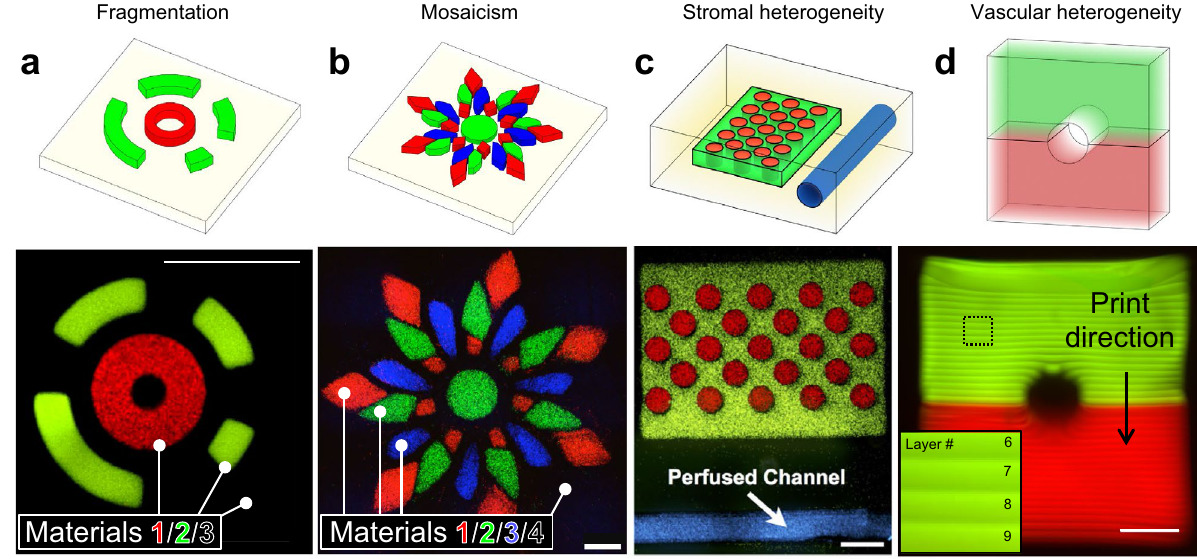
Figure 3. Multi-material printing of heterogeneous structures with broad design freedoms. ( a ) Annular hydrogel features with encapsulated fluorescent beads, printed atop a non-fluorescent base, yielding a monolithic 3-material structure with discrete, fragmented features at meso scale resolution (≈250 μm). ( b ) A 4-material floral mosaic. ( c ) A thick gel with stromal heterogeneity, featuring a hollow vessel that supported perfusion with blue fluorescent beads. ( d ) Side view of a two-component vessel (fluorescent dextrans encapsulated); inset highlights void-free covalent lamination between print layers. All scale bars = 1000